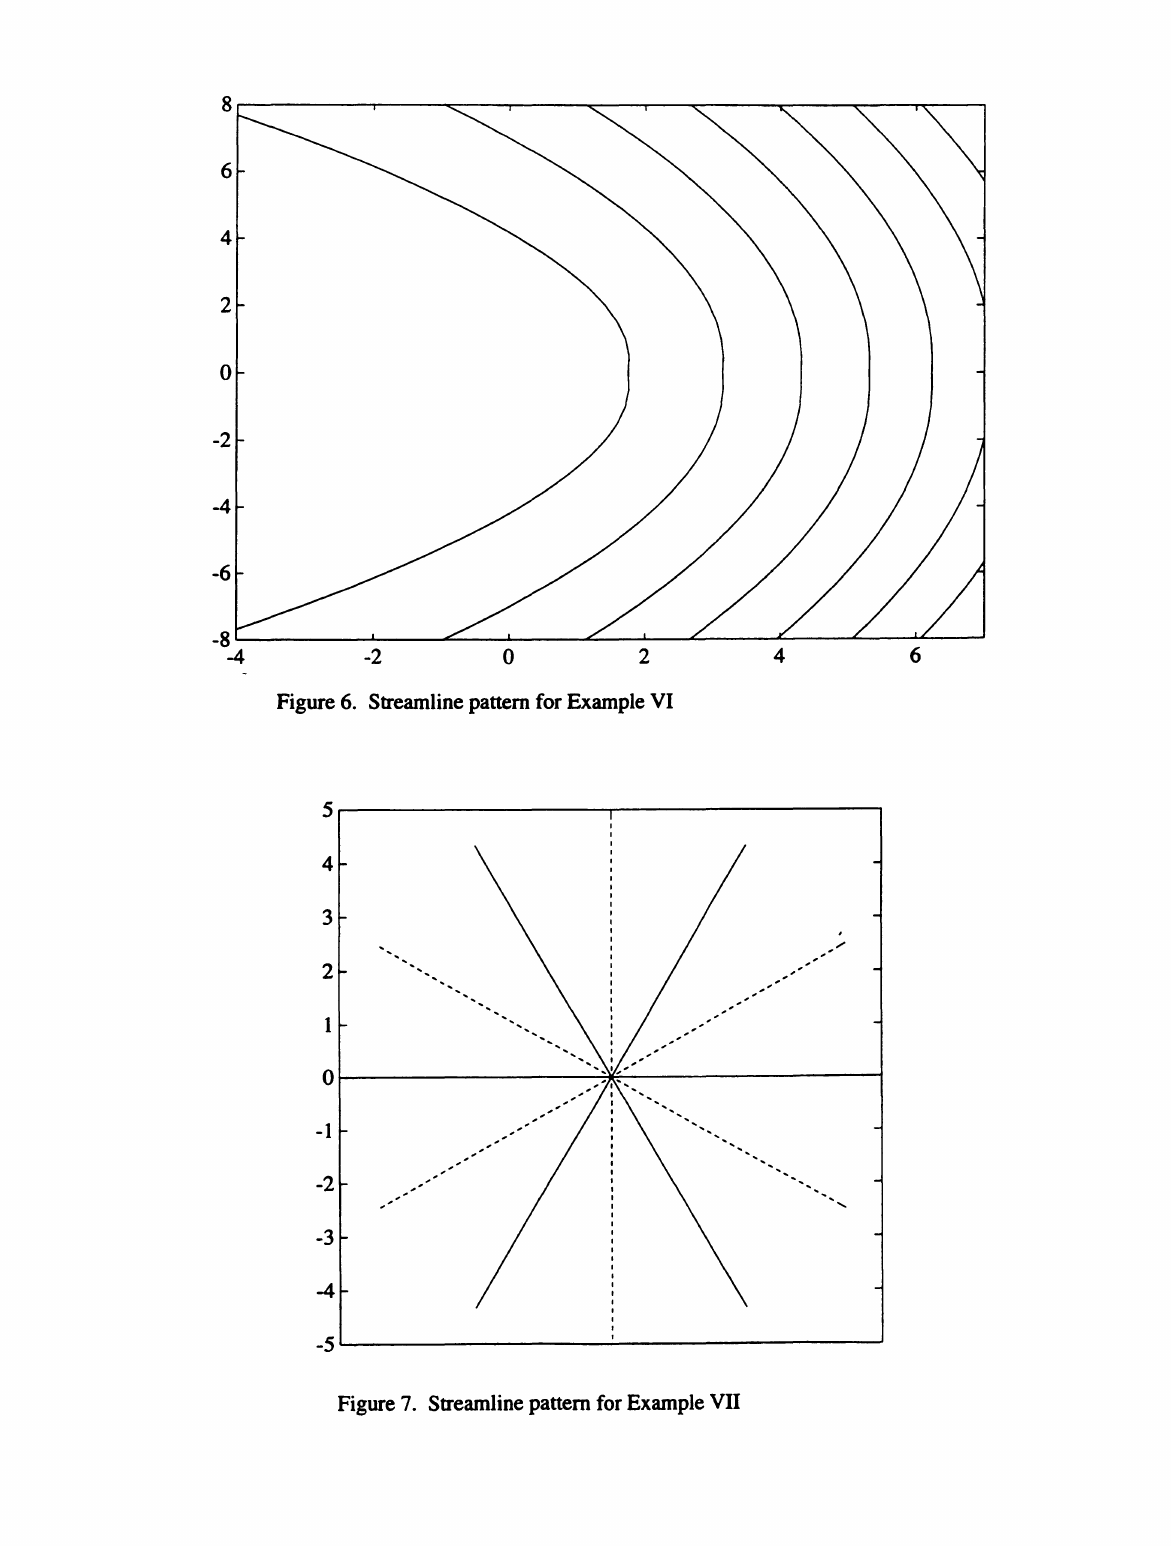
Figure 6. Streamline pattern for Example VI